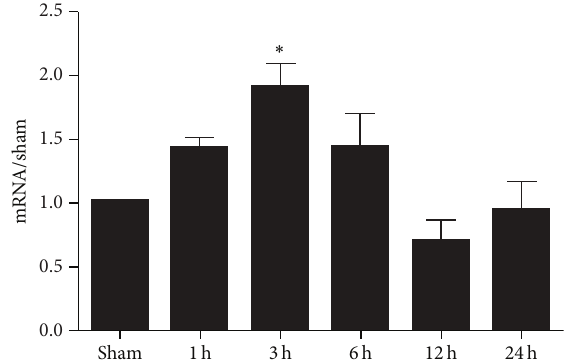
Figure 2: Time course of cathepsin S (CatS) mRNA expression in the ipsilateral cortex of mice after traumatic brain injury (TBI). The level of CatS mRNA was significantly increased at 3 h after TBI as compared with that in the sham group. 𝛽 -actin was used as an internalcontrol.Thedatawerenormalizedto 𝛽 -actinexpressionand were expressed as fold increase of the sham group. Data represent mean ± SEM ( 𝑛 = 6 ). ∗ 𝑃 < 0.05 versus sham